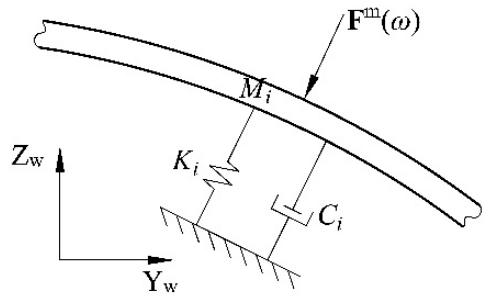
Figure 11. Schematic diagram of vibration response in the milling process in the thickness direction.